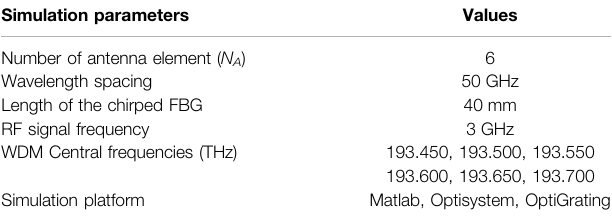
Figure 3 , while using algorithm 1 for wireless transmission. Note